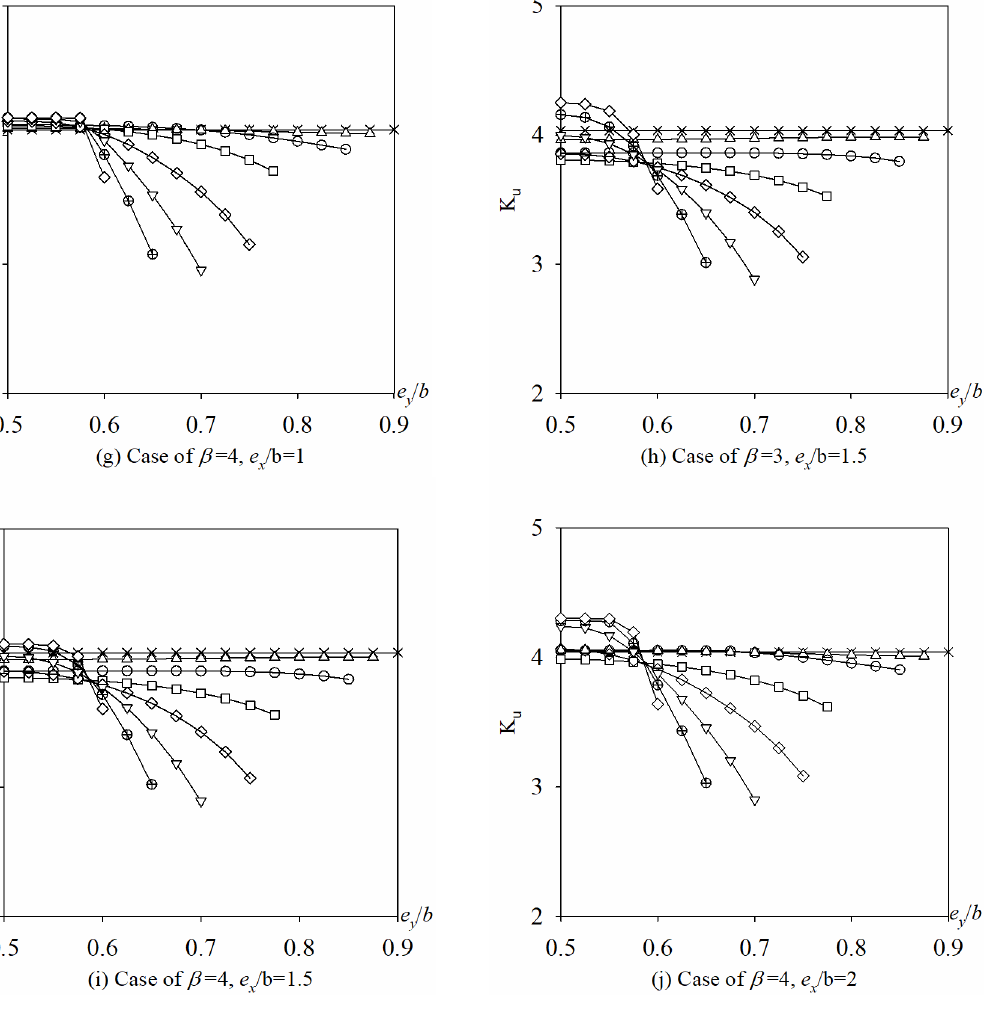
Figure 18. K u vs. e y / b for perforated rect38angular plate ( β = 1, 2, 3, 4) with the BCs of 4S.